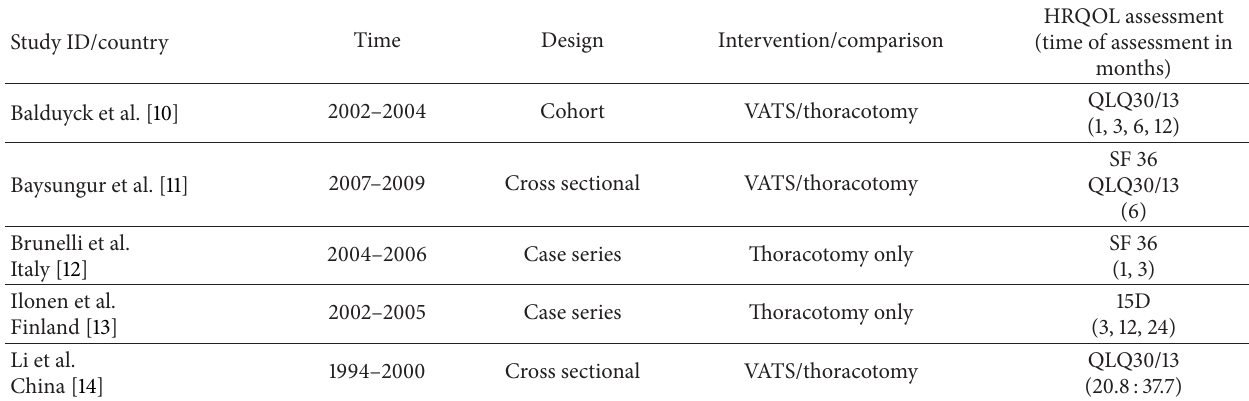
Table 2: Summary of study